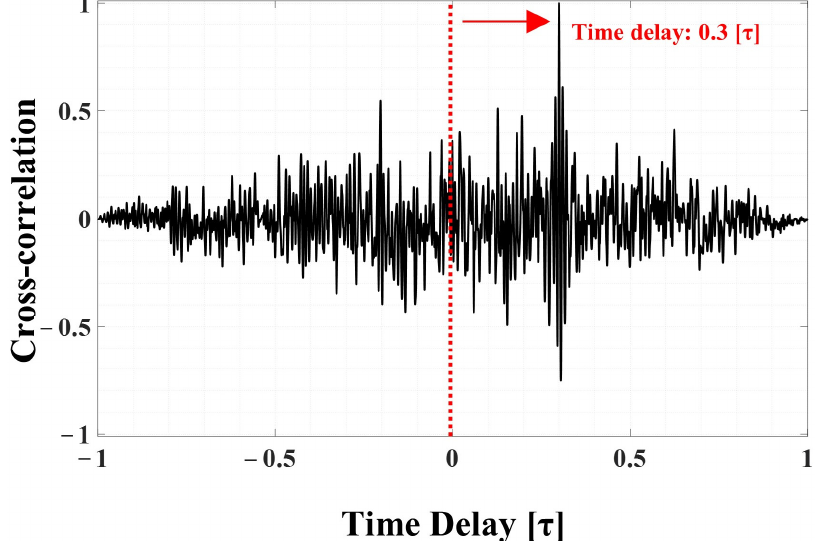
Figure 10. Cross-correlation using fi ltered signals.